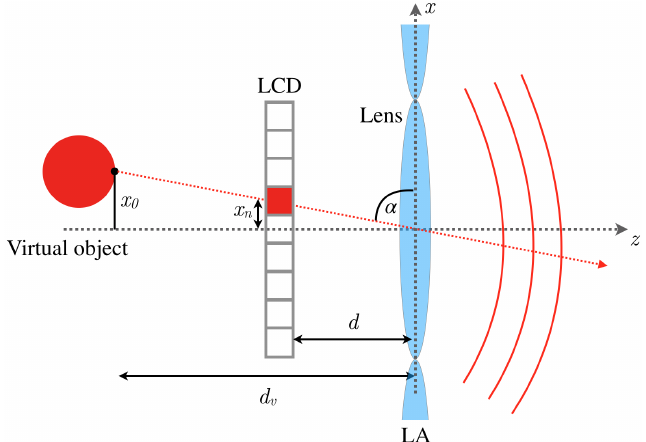
Figure 2. Schematic 3D display system and geometrical quantities. The lens manipulates the wavefront of the light emitted from the red pixel in a way, that the generated spherical wave cutout seems to originate from a point in the virtual distance d v and propagates in the direction determined by α . Multiple points can be used to create the sensation of a virtual object or even a